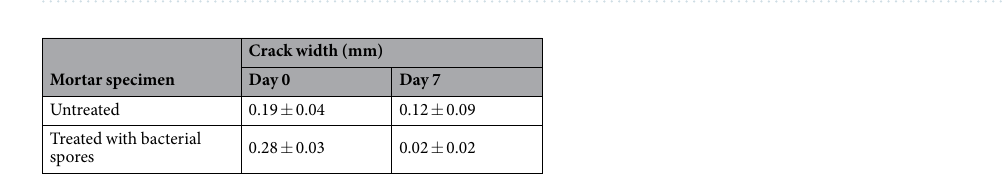
Figure 5. Crack-healing activity in mortar by sodium alginate microencapsulated bacterial spores formed by freeze drying.